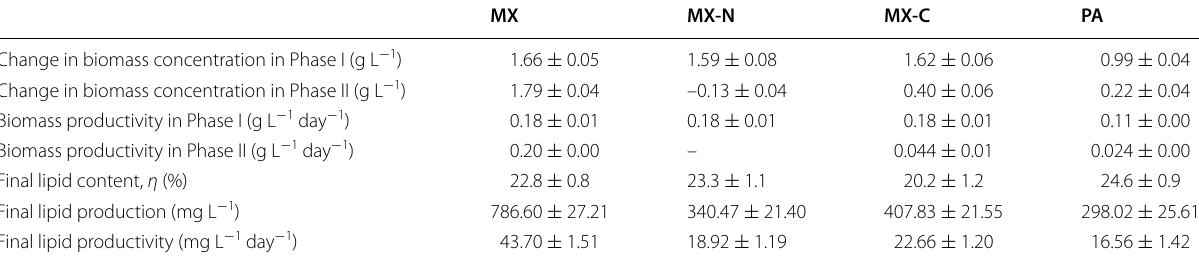
‘–’ is used to imply the numerical calculation is meaningless here